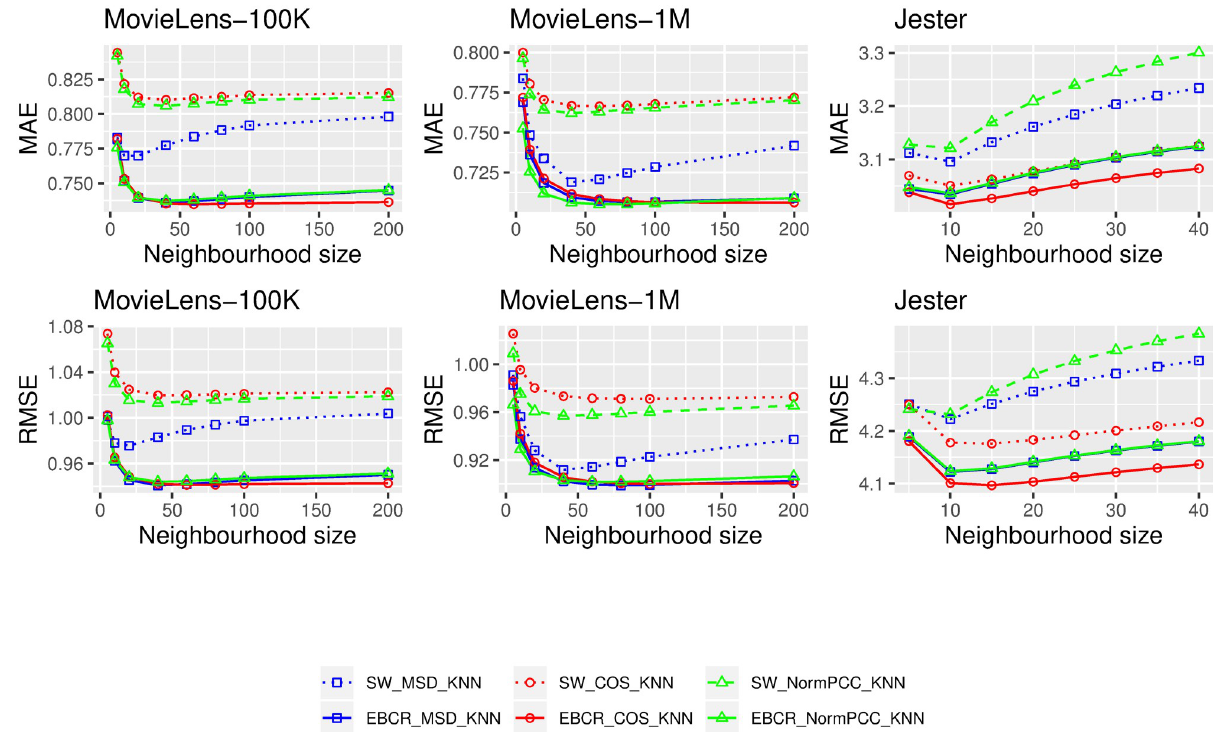
Fig 3. Comparisons of the Significance Weighting (SW) with the EBCR approach on three benchmark datasets: MovieLens-100K, MovieLens-1M and Jester.